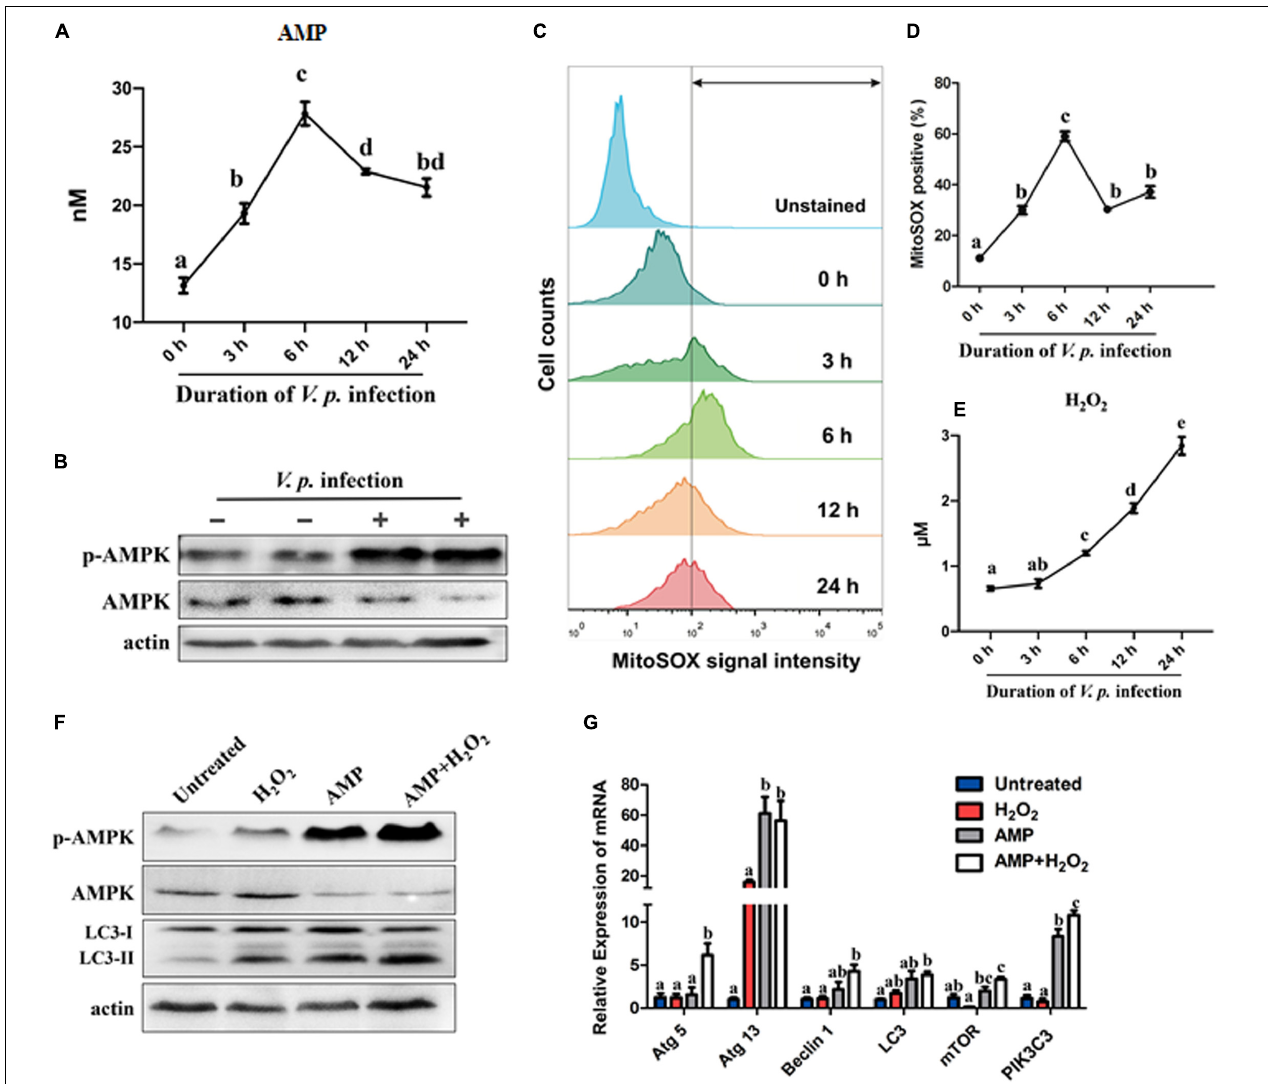
FIGURE 4 | Infection-induced AMP surplus and ROS accumulation synergistically activate AMPK and autophagy signaling. (A) Quantification of AMP in C. hongkongensis hemocytes after V.p. challenge at 0, 3, 6, 12, and 24 h determined in ELISA for AMP and normalized by total proteins (per gram). (B) Western blot showing a rise in AMPK phosphorylation 6 h post-infection. (C) Superoxide generation in oyster hemocytes at 0, 3, 6, 12, and 24 h after bacterial challenge as detected in FACS analysis with MitoSOX as a mitochondrial superoxide probe. (D) Quantification of MitoSOX fluorescence intensities. (E) Time course study on hydrogen peroxide formation at 0, 3, 6, 12, and 24 h post-infection. Data are normalized by total proteins (per gram). (F) Western blot showing the synergistic effects of AMP and H 2 O 2 on AMPK phosphorylation and autophagy induction. (G) Relative transcript expression of autophagy-related genes in the presence of AMP